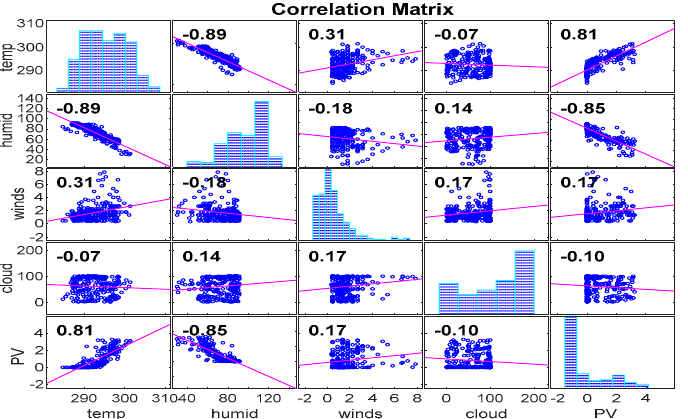
Figure 4. Example of the correlation matrix between the weather environmental variables and the produced PV power. Diagonal elements show the histogram of the variables, off-diagonal elements show the scatter plot between the variables.